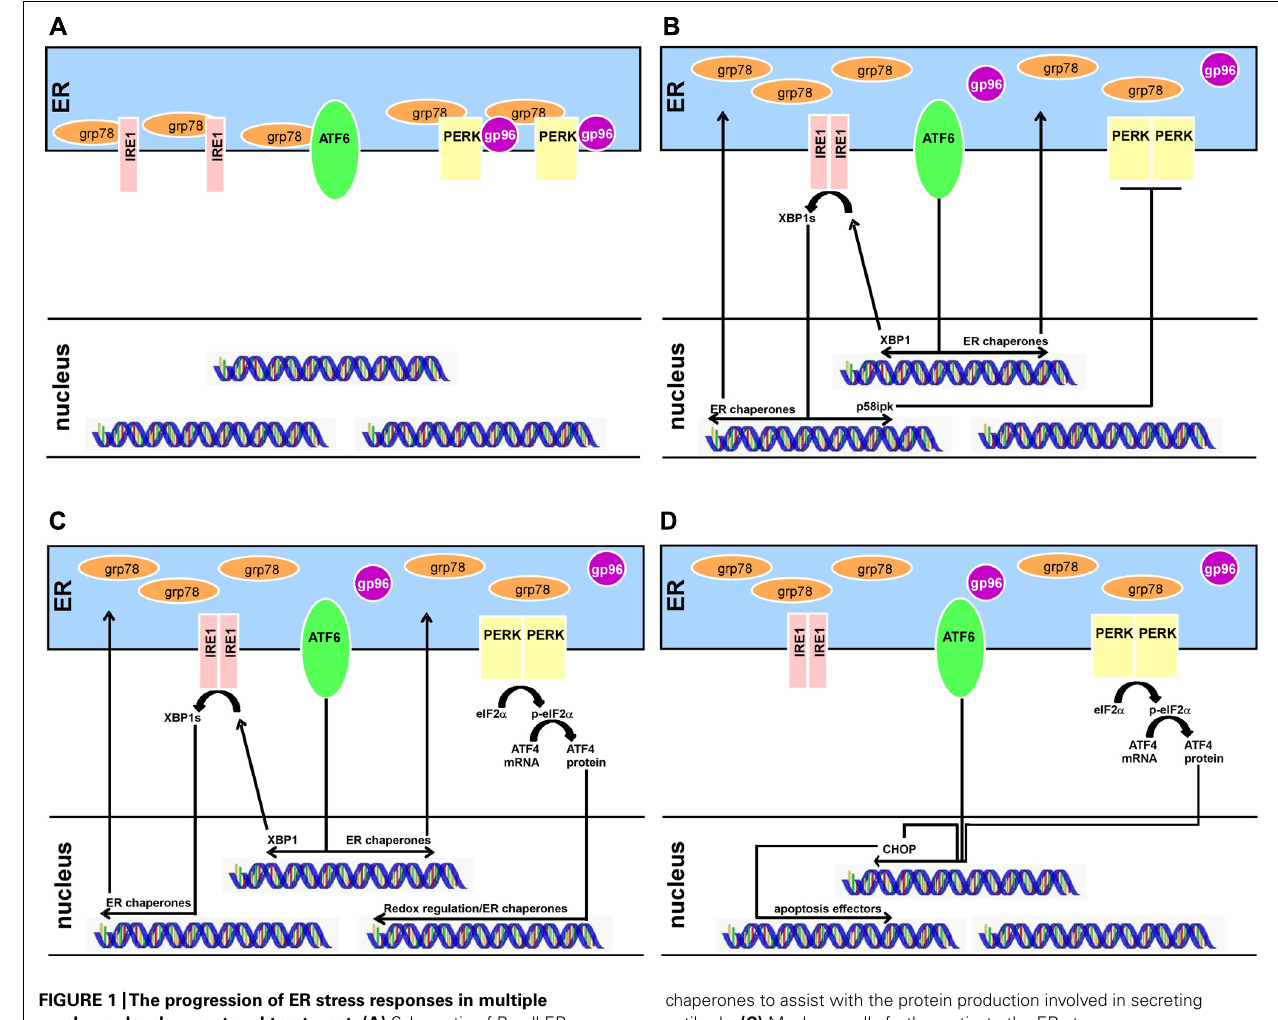
FIGURE 1 |The progression of ER stress responses in multiple myeloma development and treatment. (A) Schematic of B-cell ER stress activity before differentiation.The ER stress sensors IRE1, ATF6, and PERK are bound to ER chaperones which inhibit either homodimerization (for IRE1 and PERK) or translocation to the nucleus (ATF6).Transcriptomes downstream of the ER sensors are inactive. (B) Upon differentiation into a plasma cell, protein production is increased in a regulated fashion. Chaperones release the ER stress sensors but PERK remains inhibited through its IRE1-controlled inhibitor p58ipk. IRE1 and ATF4 upregulate ER